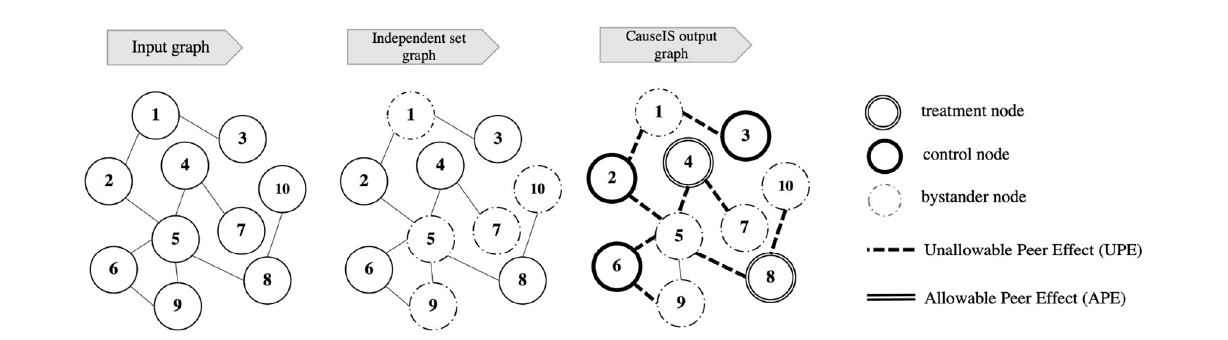
FIGURE2 Illustration of CauseIS frameworks in network experiments. Input graph : a graph of nodes and the connection between them. Independent set graph : a graph of bystander and independent set nodes selected by the independent set algorithm. CauseIS output graph : the output graph that represents randomized treatment assignment of independent set nodes and peer effects that exists in the experiment.